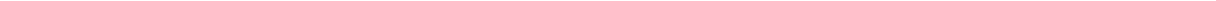
(arrowhead in u , v , compare to s , t ), but not when signaling inhibition is initiated at 24 hpf (arrowhead in w , x ). y Quanti fi cation of the concentration-